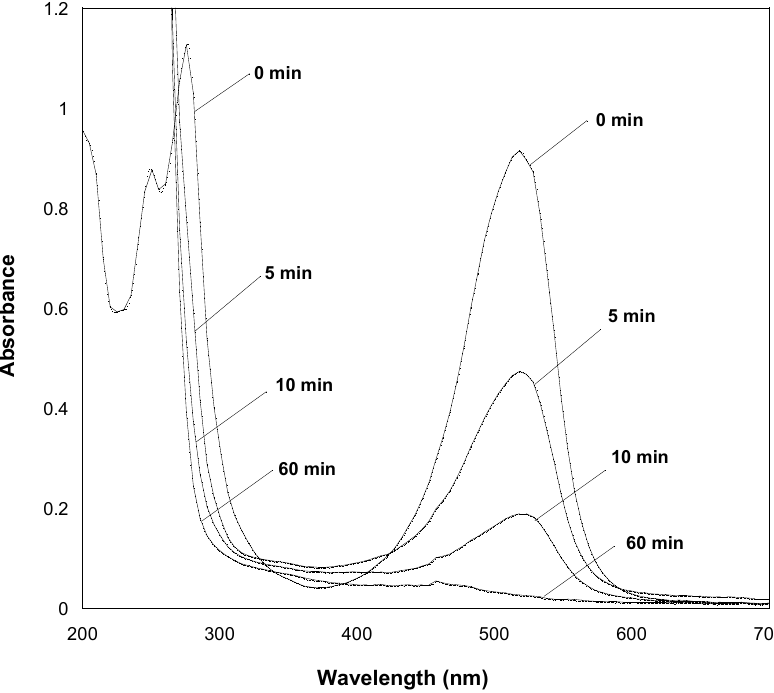
Figure 2. Temporal variation of the UV–Vis. spectra of SO solution upon treatment with UV/TiO 2 /IO 3 − process ([IO 3 − ] = 0.15 mM, [TiO 2 ] = 0.4 g∙L − 1 , [SO] = 10 mg∙L − 1 , T = 25 ± 2 °C and pH~6).